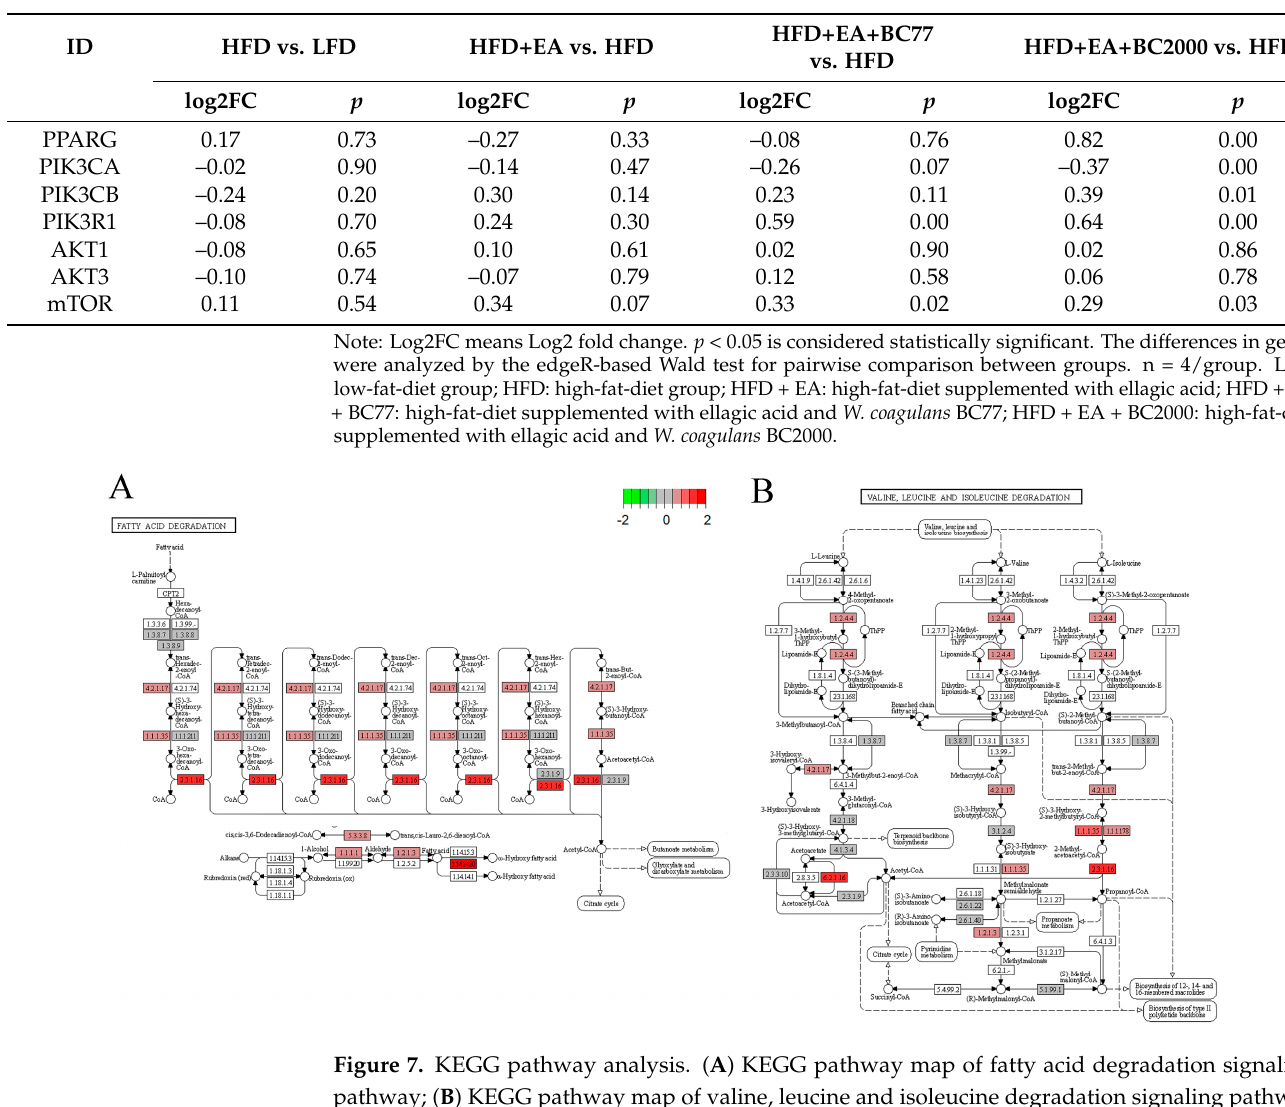
Table 3. Insulin-signaling gene expression.